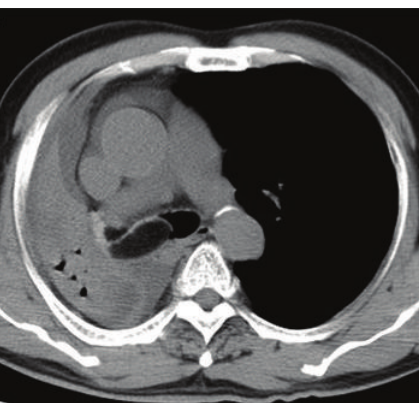
Figure 1: Axial CT showed hypodense mass in the right main bron- chus.